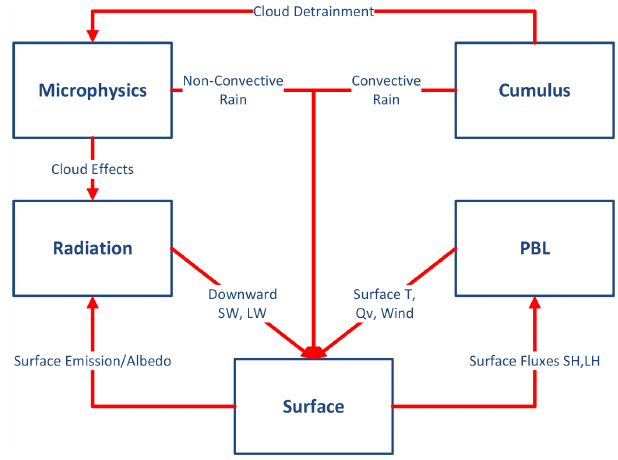
Figure 10. Schematic of physics and their interactions within a typ- ical NWP model (Dudhia,